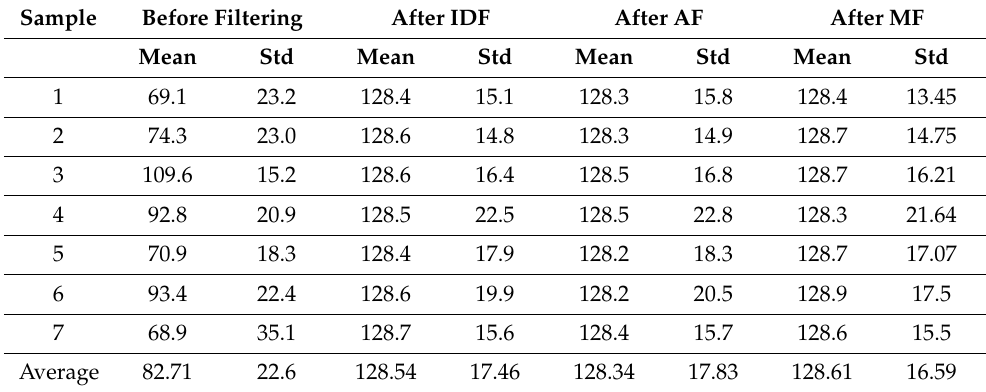
Table 1. The means and standard deviations of some images before and after